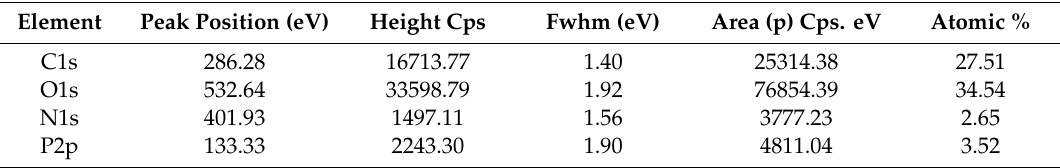
Table 1. XPS data of APBC adsorbent.